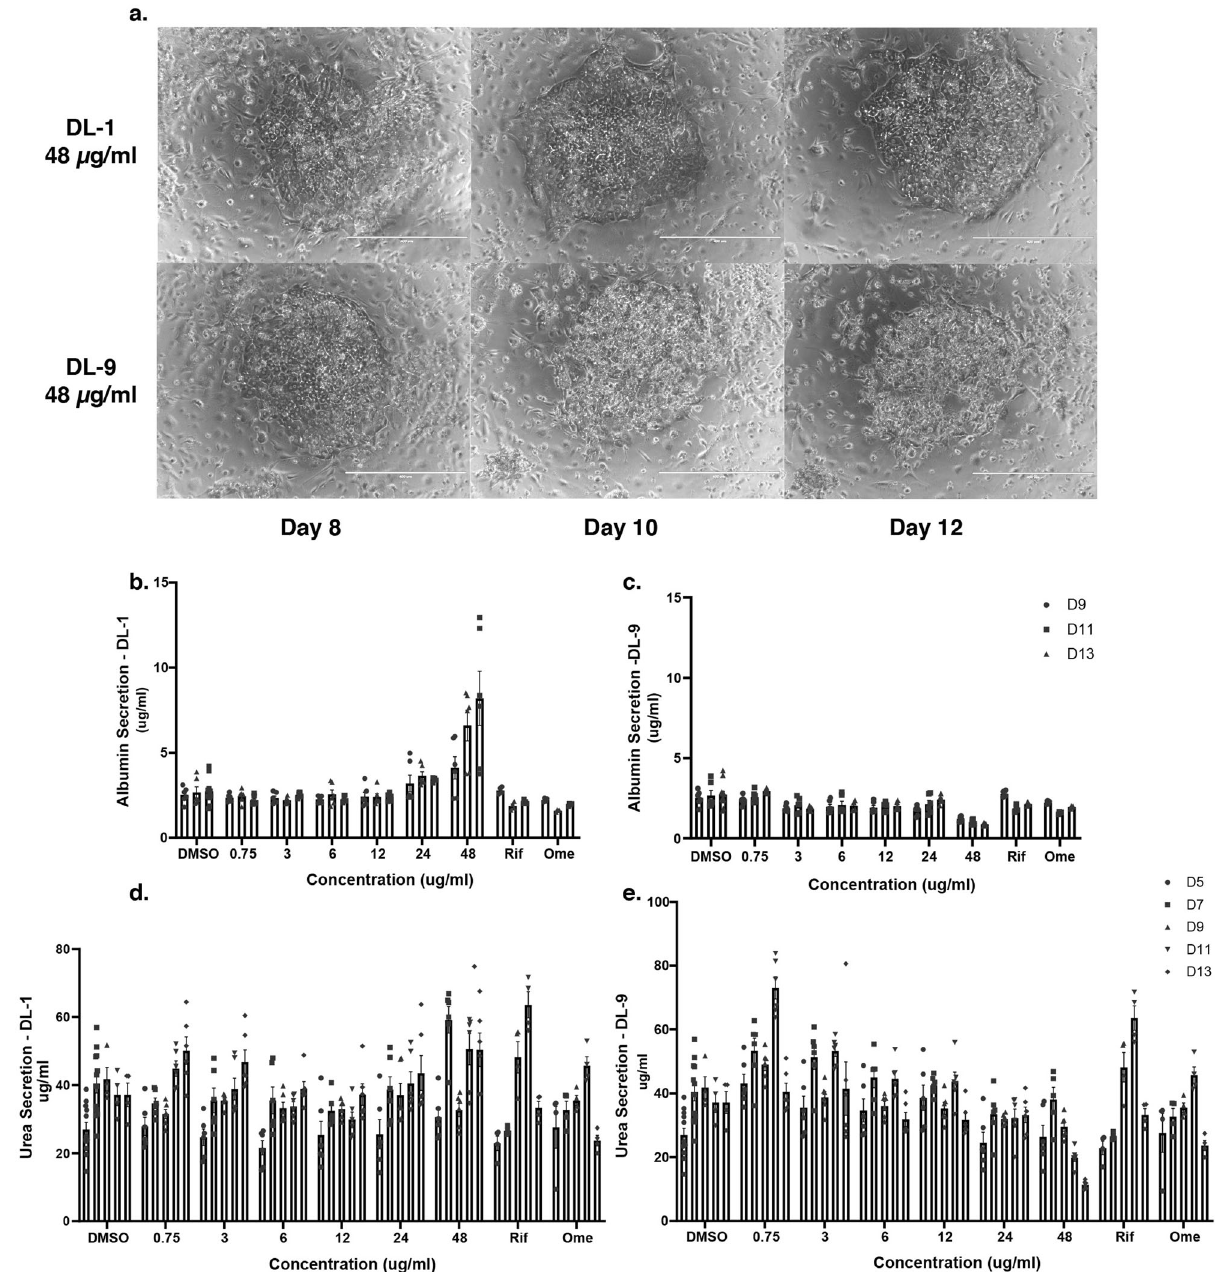
Fig. 7 Toxicology of DL-1 and DL-9 in primary human hepatocytes. a – e Micropatterned co-cultures of primary human hepatocytes were treated DL-1 or DL-9 for up to 13 days at concentrations ranging from 0.75 to 48 µ g/ml. Rifampin (25 µ M) and omeprazole (50 µ M) treated cells were included as controls. a Micrographs showing the impact of DL-1 and DL-9 on cell morphology after treatment for 8, 10, and 12 days with 48 µ g/ml of each compound. b – e Bar graphs showing the level of Albumin ( b , c ) and Urea ( d , e ) in the medium of hepatocytes treated with 0.75, 3, 6, 12, 24, and 48 µ g/ml of DL-1 or DL-9 for 9, 11, or 13 days ( b , c ) or 5, 7, 9, 11, and 13 days ( d , e ). Data presented as mean ± SD of three technical replicates ( n = 3) and statistical analysis was performed using two-way